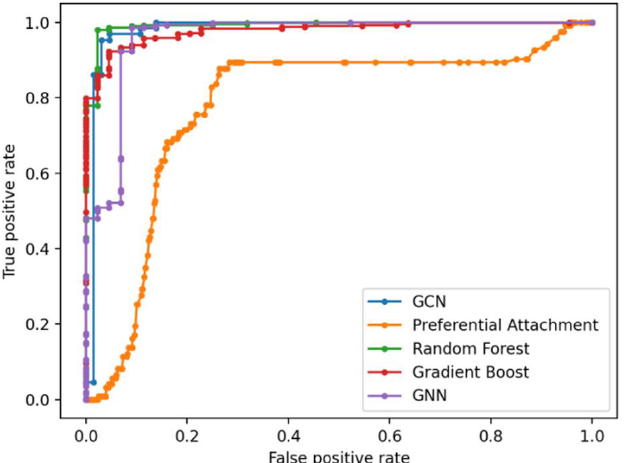
Figure 6. Receiver Operating Characteristic (ROC) curve showing the true positive and false positive scores for link prediction in the DDKG using the five methods. Table 2. Ten-fold cross validation accuracies for link prediction using RF, Gboost, and GNN in GDKG.